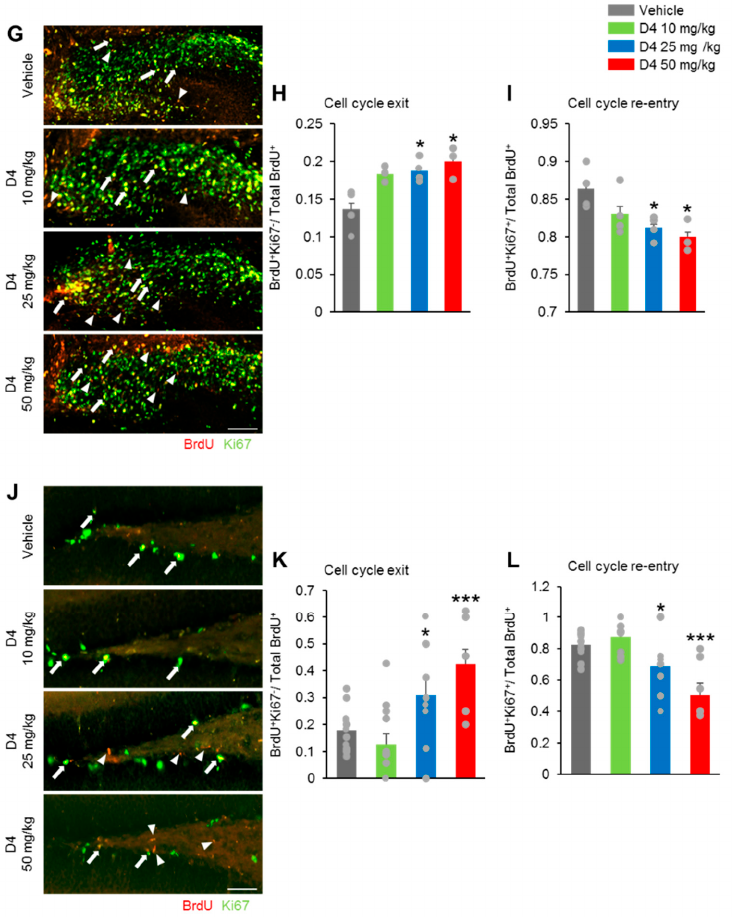
Figure 4. Prenatal D4 impairs neural progenitor cell premature differentiation and maintenance in vivo. Nuclei of cells in S phase of cell cycle in confocal sections of the dentate gyrus area are labeled using BrdU antibody (red) and progenitor cells are labeled using Ki67 (green) on confocal sections of the dentate gyrus area. Brains of vehicle and D4 − treated groups at E17.5 ( A ) and offspring mice ( D ) were dissected. ( B , C ) Quantification analysis of ( A ). ( B ) The number of BrdU + cells were decreased in the D4 25 mg/kg and D4 50 mg/kg groups compared to vehicle group at E18.5 (F 3,25 = 5.840, p = 0.0143). ( C ) The number of Ki67 + cells were decreased in the D4 25 mg/kg and D4 50 mg/kg groups compared to vehicle group (F 3,25 = 6.215, p = 0.0086), ( n = 5–7 per group). ( E , F ) Quantification analysis of ( D ). ( E ) The number of BrdU + cells were also decreased in the D4 25 mg/kg and D4 50 mg/kg groups compared to vehicle group (F 3,27 = 6.689, p = 0.0002). ( F ) D4 25 mg/kg and D4 50 mg/kg groups displayed lower in the number of Ki67 + cells (F 3,24 = 5.709, p = 0.0007), ( n = 7–10 per group). The cell cycle exit rate was determined by dividing the number of BrdU − positive/Ki67 − negative cells by the total number of BrdU − positive cells and the cell cycle re − entering was determined by dividing the number of BrdU − positive/Ki67 − positive cells by the total number of BrdU − positive cells. At E17.5 dentate gyrus ( G – I ), the proportion of cells exiting the cell cycle in the D4 25 mg/kg and D4 50 mg/kg groups was markedly higher in the vehicle group (F 3,25 = 6.487, p = 0.0036). D4 25 mg/kg and D4 50 mg/kg groups showed lower in the number of cells re − entering the cell cycle compared to the vehicle group (F 3,25 = 4.627, p = 0.0251). At adult dentate gyrus area ( J – L ), D4 25 mg/kg and D4 50 mg/kg groups showed increased proportion of cells exiting the cell cycle compared to vehicle group (F 3,27 = 8.308, p < 0.0001). Moreover, the number of cells re − entering the cell cycle in the D4 25 mg/kg and D4 50 mg/kg groups were lower compared to vehicle group (F 3,27 = 8.500, p < 0.0001). n = 7–10 per group. Data represent mean ± SEM. Statistical significance was determined by one − way ANOVA with Bonferroni correction. * p < 0.05 vs. vehicle, *** p < 0.001 vs. vehicle. Scale bars: 50 μ m.